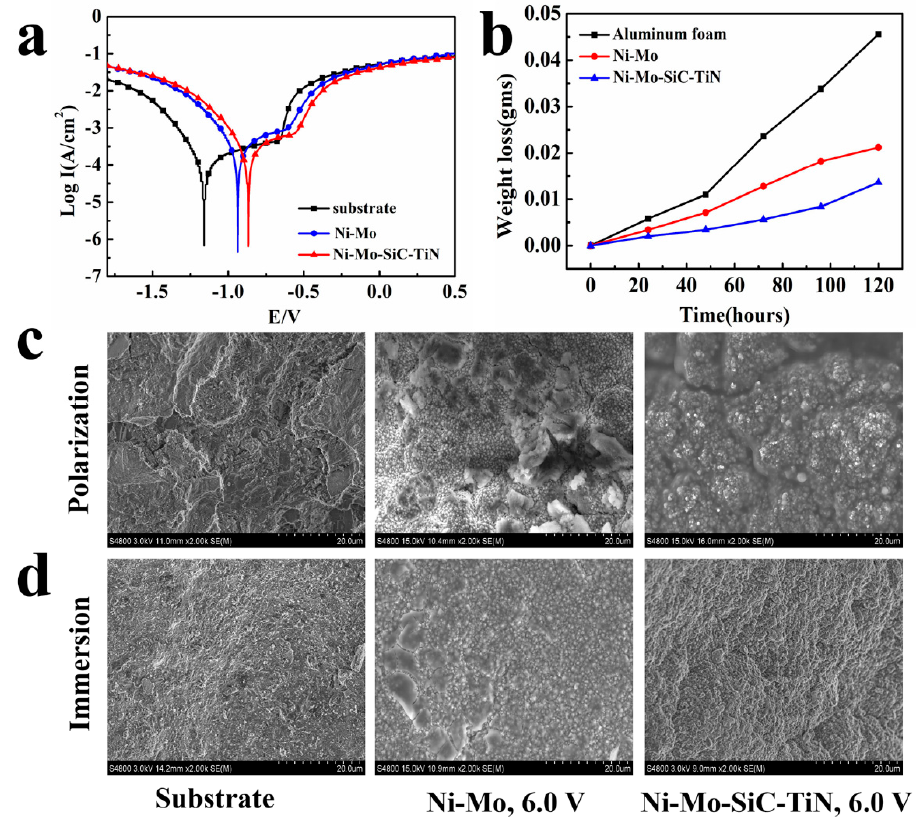
Figure 7. The polarization curves of the samples ( a ) and weight loss versus time curves after the immersion test ( b ); SEM images of the substrate and coatings after the polarization test ( c ) and immersion test ( d ).